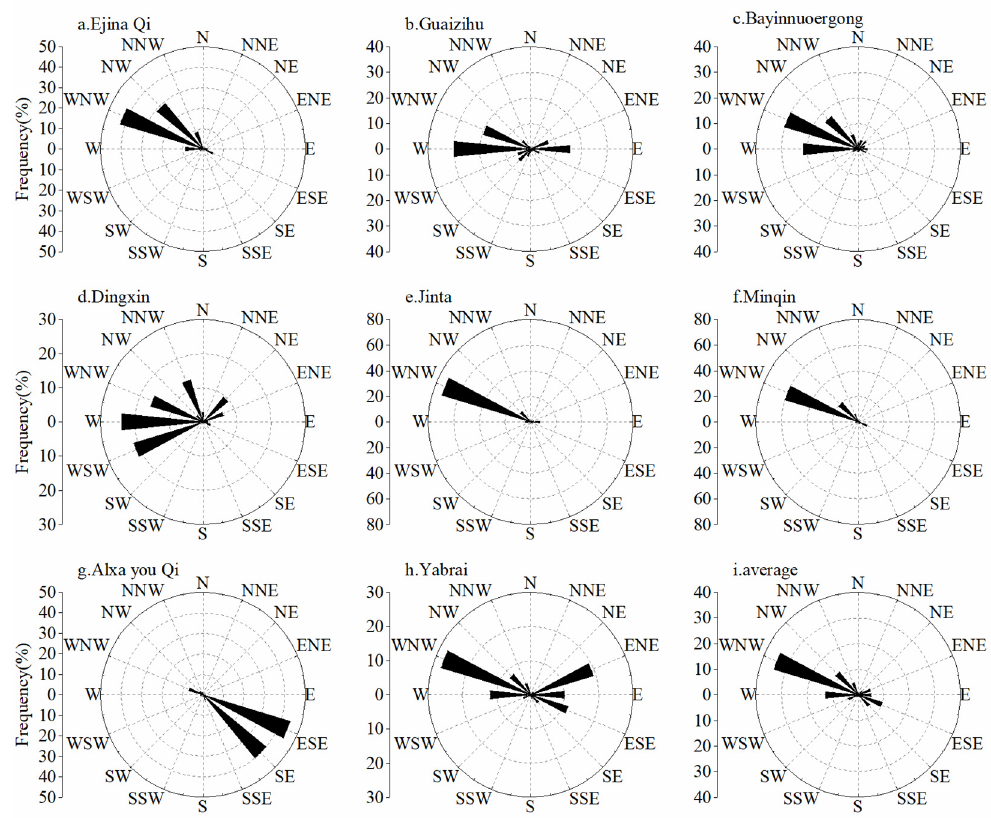
Figure 6. Wind roses of sand-blowing wind at ( a ) Ejina Qi, ( b ) Guaizihu, ( c ) Bayinnuoergong, ( d ) Dingxin, ( e ) Jinta, ( f ) Minqin, ( g ) Alxa you Qi, ( h ) Yabrai and ( i ) BJD.